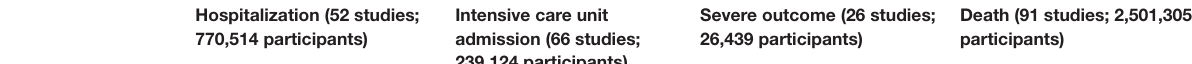
Severe outcome (26 studies; 26,439 participants)